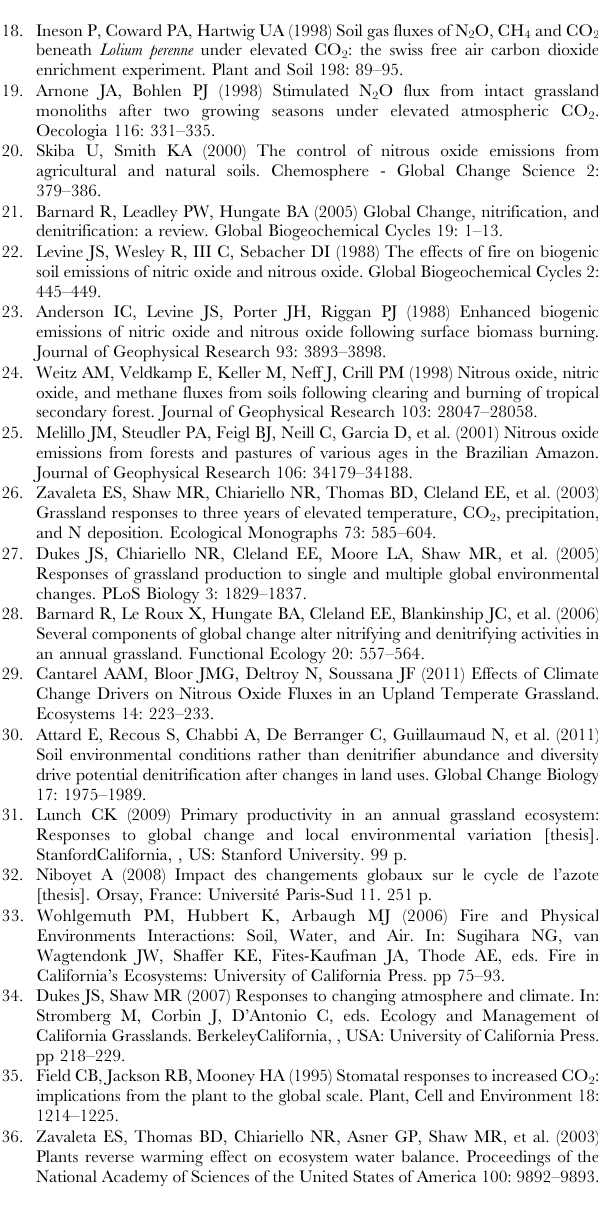
Table S9 Treatment effects on potential ammonia and nitrite oxidation year two after fire (n= 80 6 2 sampling dates – 19 and 21 months after fire). Treatments are burn (B), elevated CO 2 (CO 2 ), increased precipitation (W), and N supply (N). Significant responses are indicated in bold ( a = 0.05). The overall effect of the burn treatment was calculated as: % effect = 100 6 [burned 2 unburned]/unburned (n =32 6 2 in the burned plots, n =48 6 2 in the unburned plots). The overall effects of the CO 2 , precipitation, and N treatments were calculated as: % effec- t = 100 6 [elevated 2 ambient]/ambient (n= 40 6 2 in the elevated and ambient